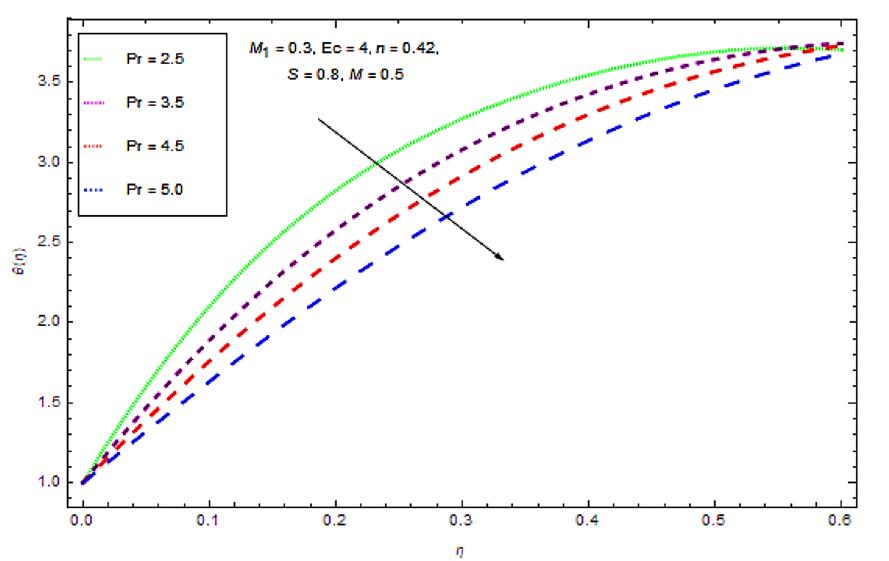
Figure 11. Effect of Pr on θ(η)